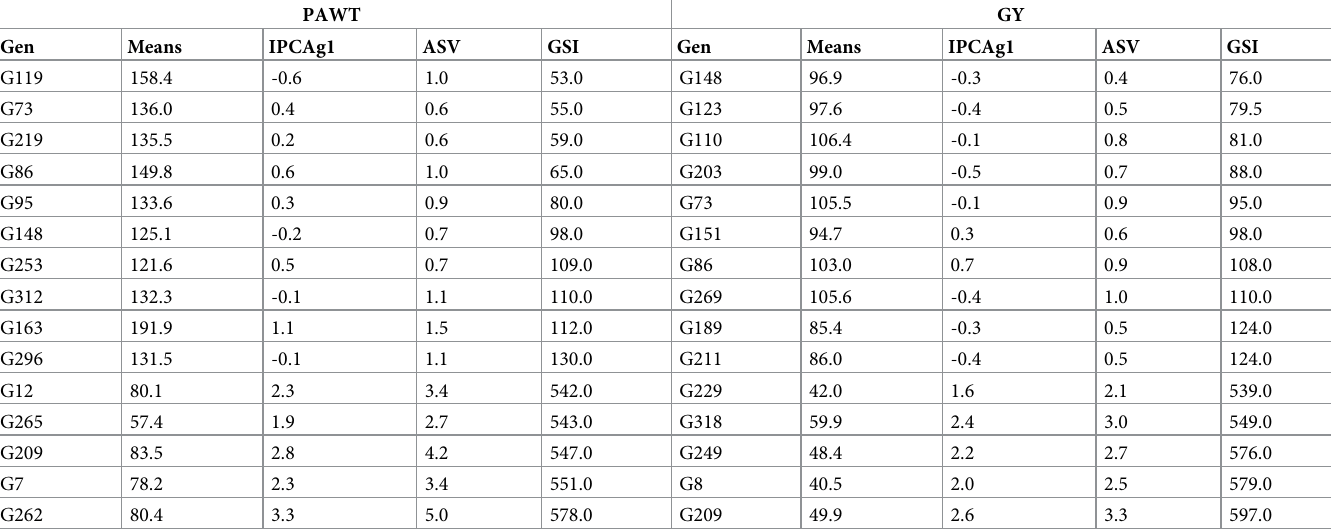
Table 6. The ASV, GSI and combined mean performance of the top ten and bottom five genotypes for grain yield and panicle weight. PAWT GY Gen